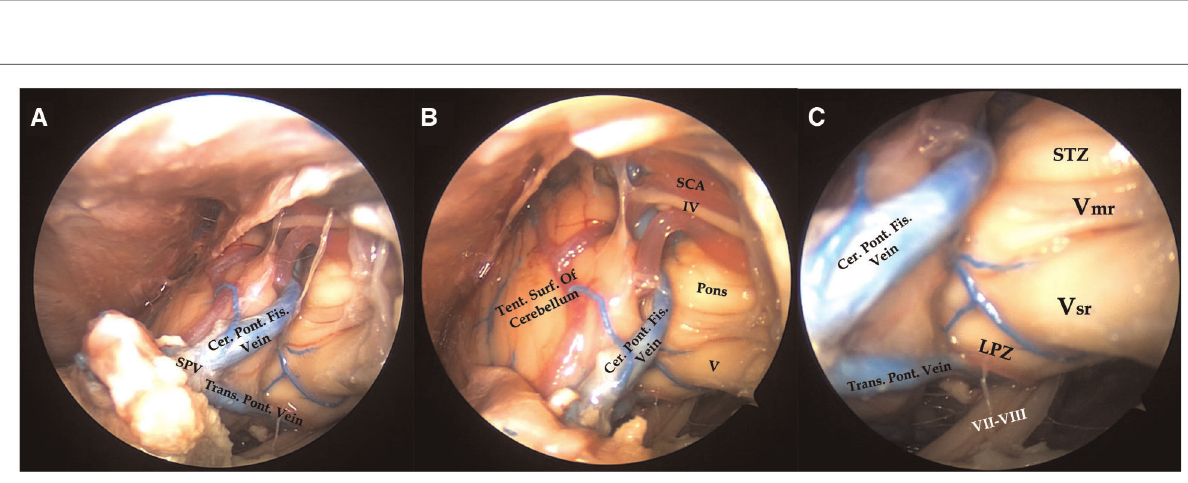
FIGURE 5 Right endoscopic transorbital approach to the tentorial incisura. After superomedial retraction of the margin of the tentorium, the contents of the middle incisural space are exposed ( A ). Cisternal segment of the trochlear nerve running along the superior surface of the superior cerebellar artery, lateral surface of the pons, the origin of the trigeminal root, and vein of the cerebellopontine fi ssure joining to the superior petrosal vein are visualized ( B ). By means of a 30° lens, directing the endoscope inferomedially, the vestibulofacial bundle is exposed in its course to the internal acoustic meatus, along with the transverse pontine vein joining the superior petrosal vein ( C ). IV, trochlear nerve; V, trigeminal nerve; Vsr, sensory root of the trigeminal nerve; Vmr, motor rootlets of the trigeminal nerve; VII – VIII, vestibulofacial bundle; Cer. Pon. Fis. Vein, Cerebellopontine fi ssure vein; LPZ, lateral pontine zone; SCA, superior cerebellar artery; SPV, superior petrosal vein; STZ, supratrigeminal zone; Tent. Surf. of Cerebellum, tentorial surface of the cerebellum; Trans. Pon. Vein, transverse pontine